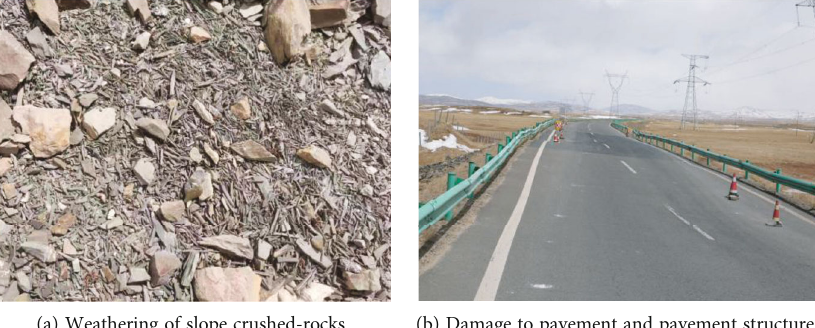
Figure 2: Qinghai Province ’ s Gongyu high-grade highway